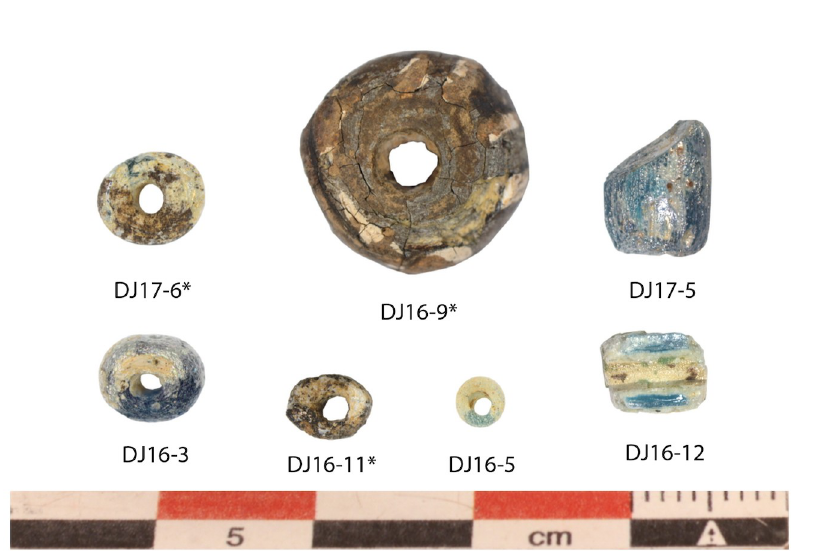
Fig 4. Glass beads found in Djoutoubaya, Senegal. The three deteriorated beads not subjected to chemical analysis are indicated with “ � ”.